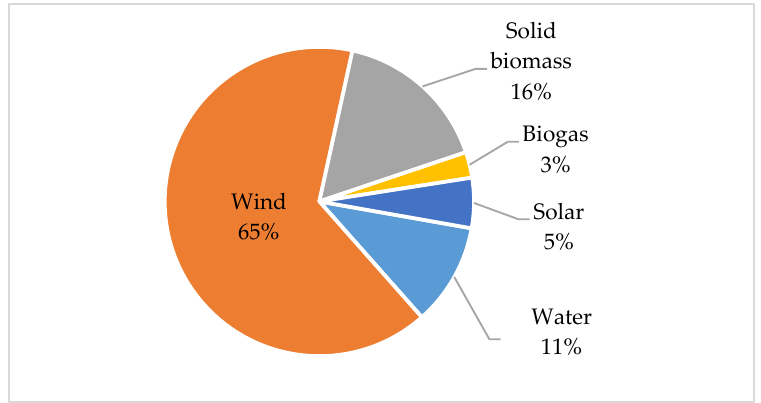
Figure 2. Installed renewable energy sources according to the share of sources (as at 31 December 2019) [7].